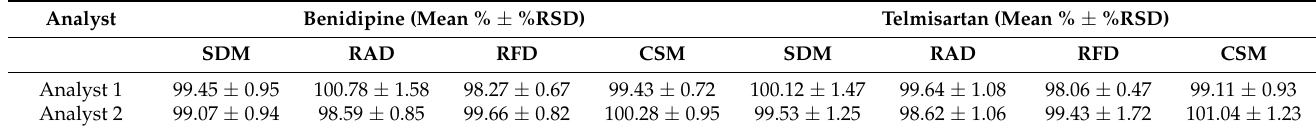
Table 3. Ruggedness results.